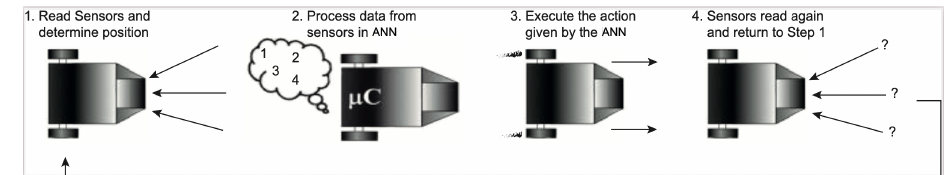
Figure 14. Decision-making algorithm using